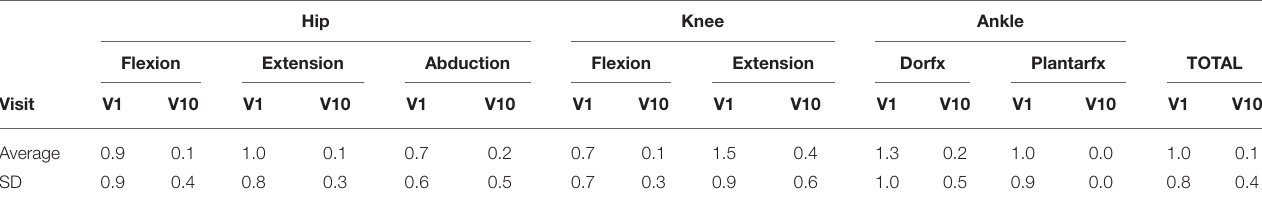
TABLE 3 | Average spasticity measured for both legs of the three patients for the different movements assessed at the initial (V1) and final (V10) visits of the study, measured by the